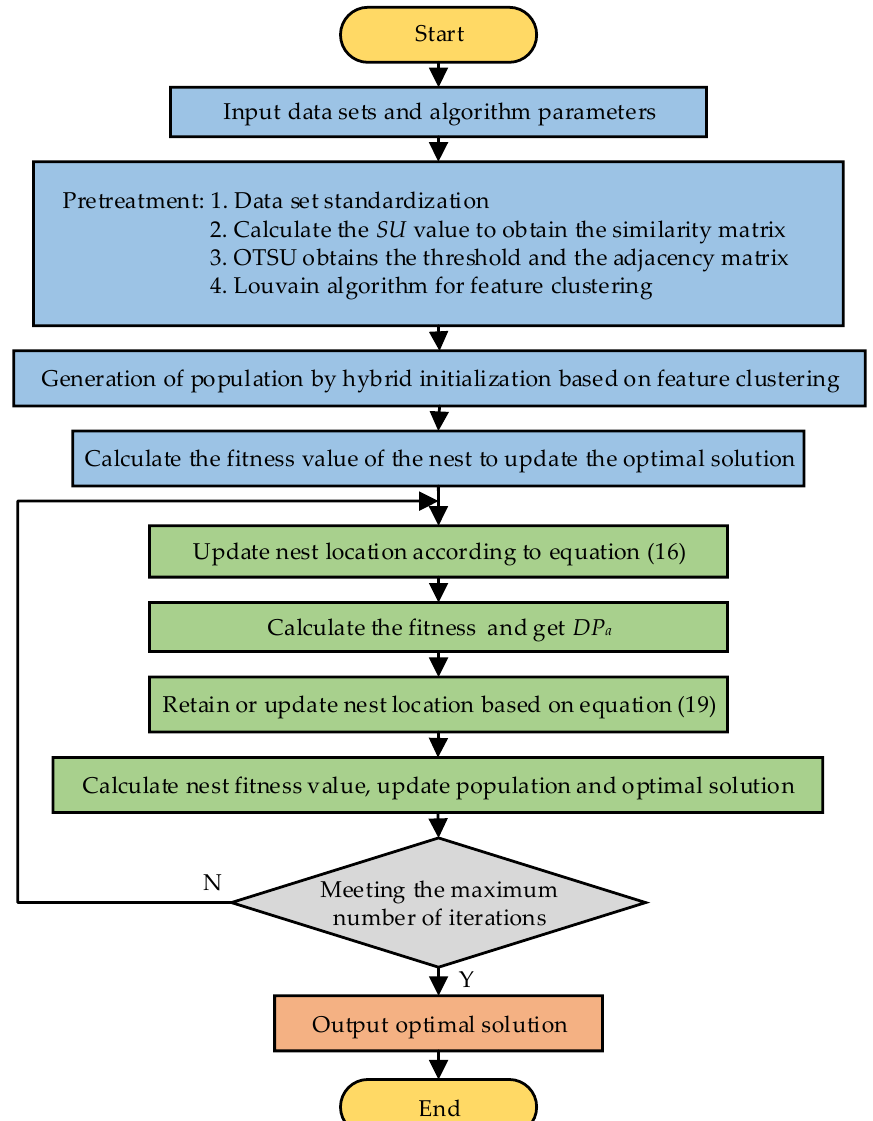
Figure 6. Flowchart of the CHBCS algorithm.